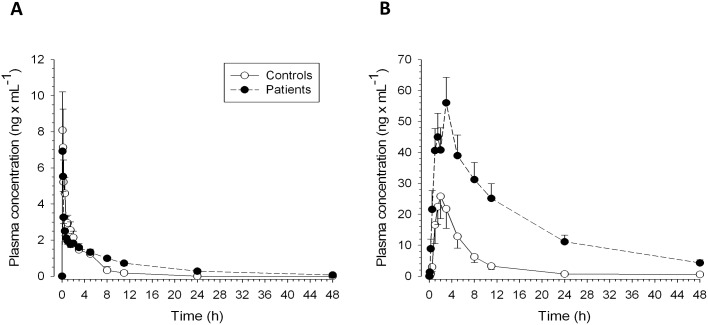
Propranolol plasma concentration versus time profiles after (A) intravenous (1 mg) and (B) oral (40 mg) application.Plasma concentrations were determined using high-performance liquid chromatography (HPLC). See Table 2 for calculated pharmacokinetic variables.